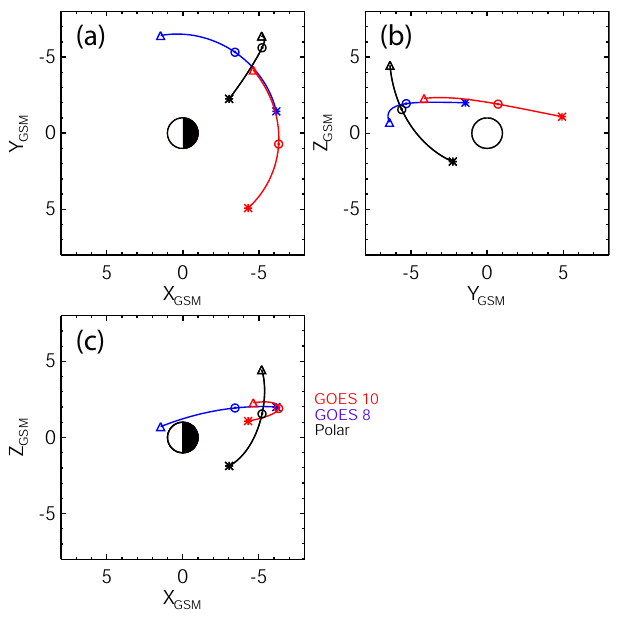
Fig. 2. Plots of the GOES 8 (blue), GOES 10 (red) and Polar (black) orbital positions between 06:00 and 12:00UT in the (a) XY , (b) YZ and (c) XZ in GSM coordinates. The locations of the space- craft at 06:00, 09:00 and 12:00UT are represented by asterisks, open circles and triangles, respectively.